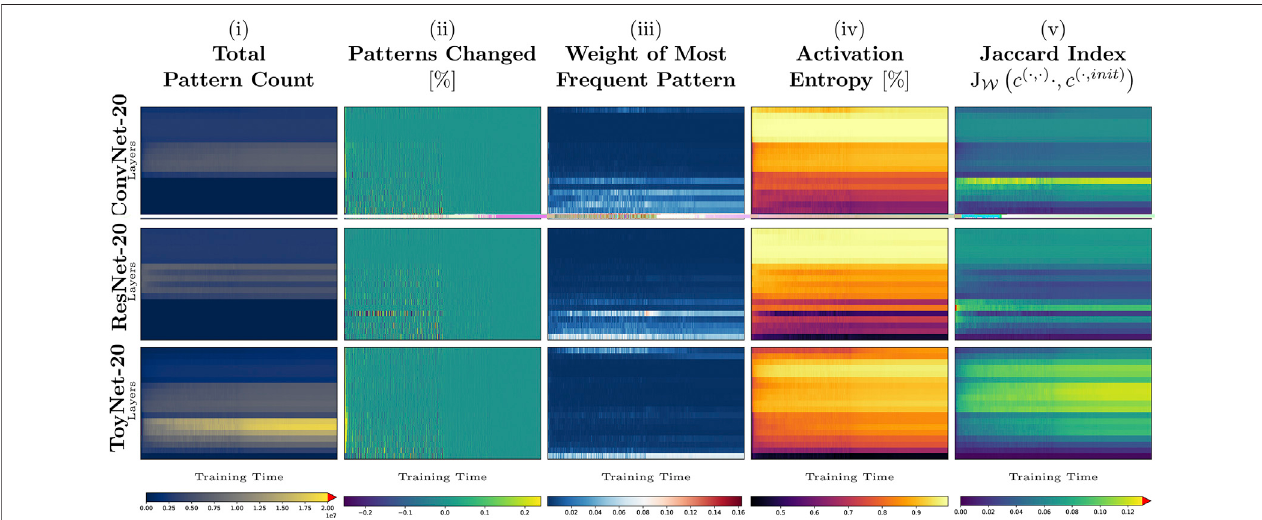
FIGURE 4 | Full training phase (of 200 epochs) of ToyNet-20 (A) , ConvNet-20 (B) , and ResNet-20 (C) . The plots correspond to those in Figure 1 , showing the measures from left to right: total pattern count, patterns changed, weight of most frequent pattern, the activation entropy, and the Jaccard index between the current network state and the initial network